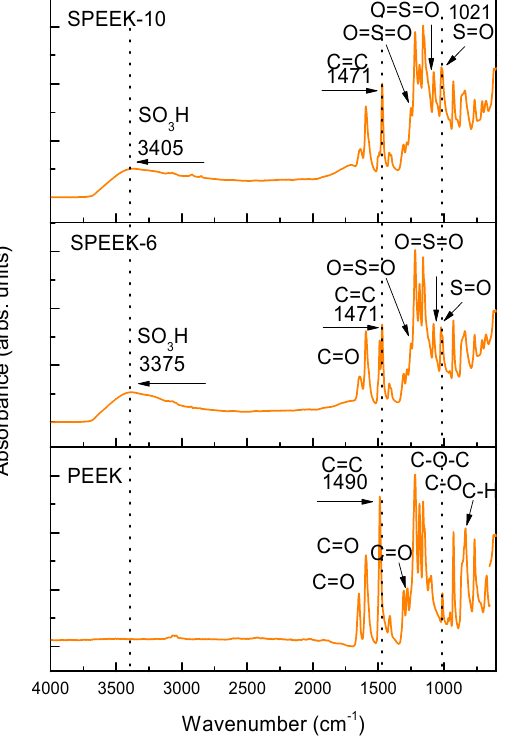
Figure 3. The FTIR spectra of PEEK, PEEK with a w / v ratio of 6% (SPEEK−6), and PEEK with a w / v ratio of 10% (SPEEK−10).